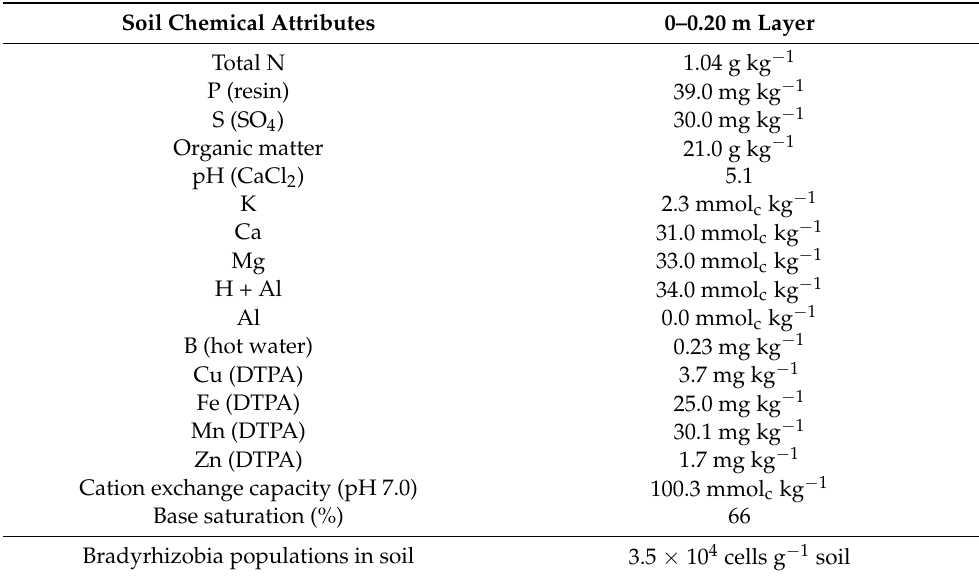
Table 1. Soil chemical attributes and Bradyrhizobia populations in soil in 0–0.20 m layer before field trial